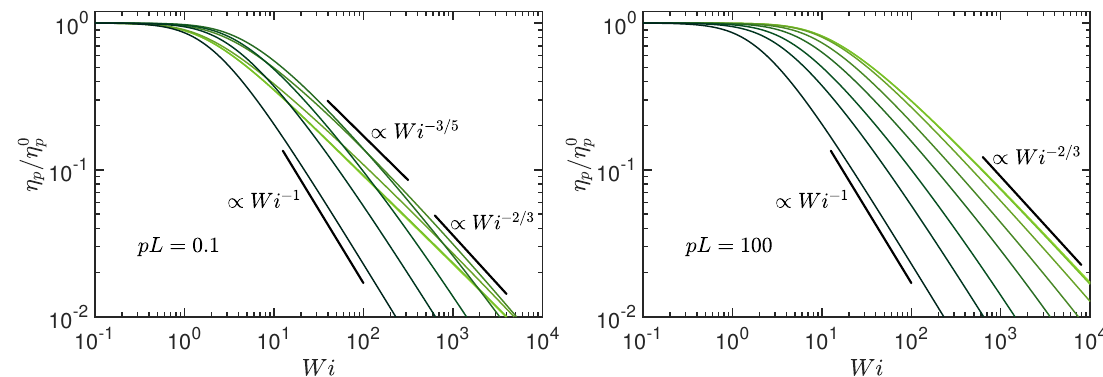
Figure 10. Shear viscosity η p normalized by the viscosity η 0 p of a non-sheared, active polymer as function of the Weissenberg number Wi for the Péclet numbers Pe = 0, 0.6, 3, 10, 30, 10 2 ,3 × 10 2 , and ∞ (bright to dark color); ( left ) pL = 0.1 and ( right ) pL = 10 2 . The number of active sites is L / l = 10 2 and ∆ =